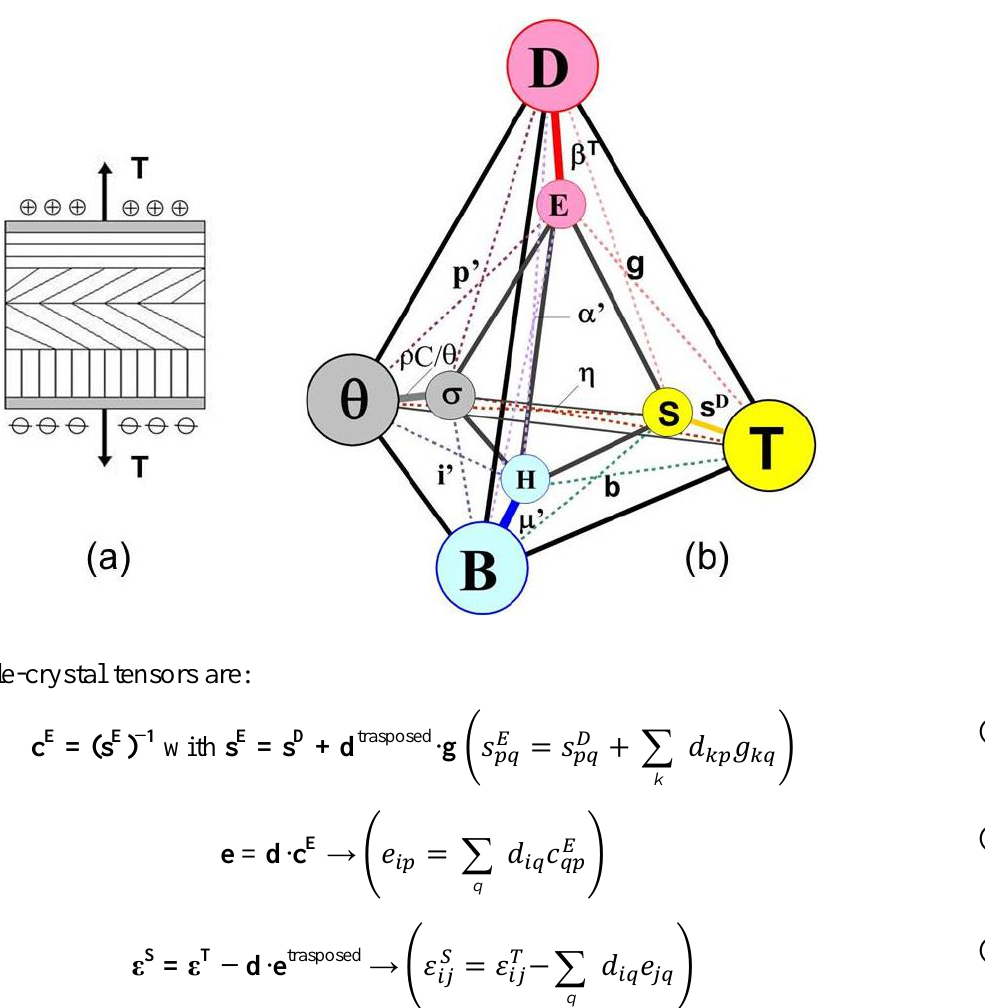
Figure 2. ( a ) A polycrystal in ideal series arrangement during a piezoelectric experiment. Suitable independent variables are stress and electric charge; ( b ) Graphical representation of principal and coupling interactions. Reuss